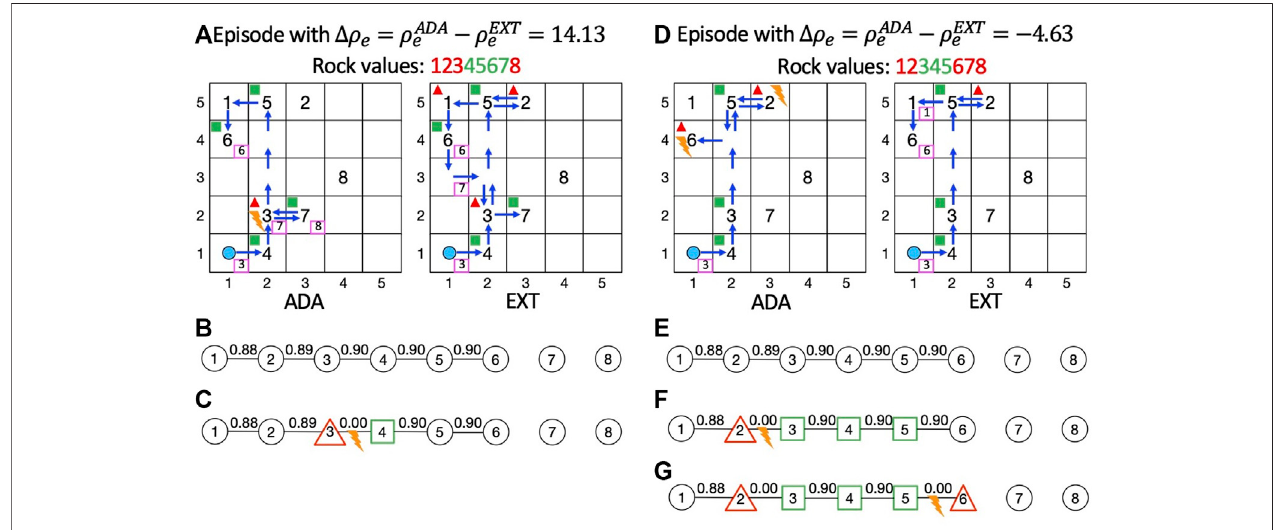
FIGURE 9 | (A) Relevant actions of the execution traces of an episode with a positive Δ ρ e between ADA (on the left) and EXT (on the right). (B) Initial MRFs (learnt). (C) Adapted MRF, P ( 3 , 4 ) (cid:2) 0. (D) Relevant actions oftheexecution tracesofanepisodewitha negative Δ ρ e betweenADA(ontheleft) andtheuseofEXT(ontheright). (E) Initial MRFs (learnt). (F) MRF after the fi rst adaptation, P ( 2 , 3 ) (cid:2) 0. (G) MRF after the second adaptation, P ( 5 , 6 ) (cid:2)